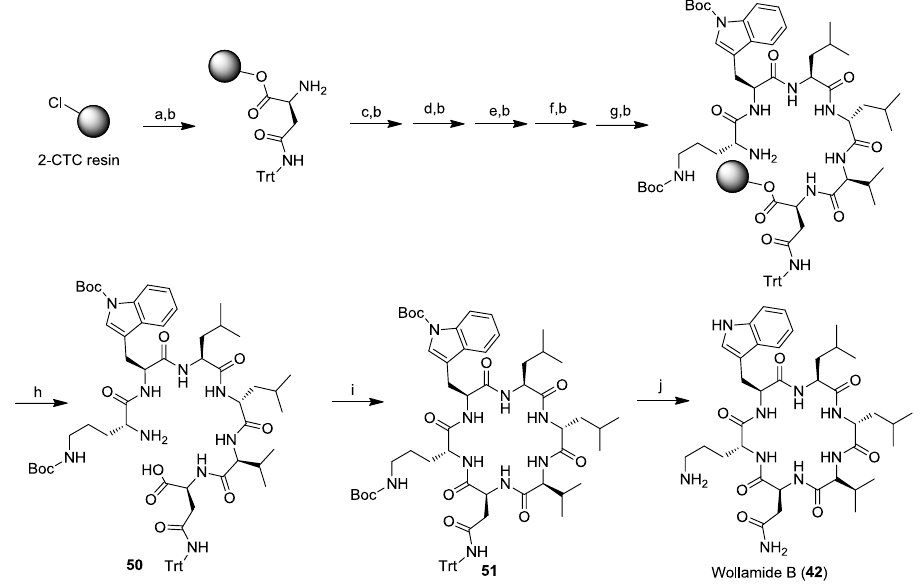
Scheme 9. Solid-phase peptide synthesis of 42 on 2-chlorotrityl chloride (2-CTC) resin. Reagents and